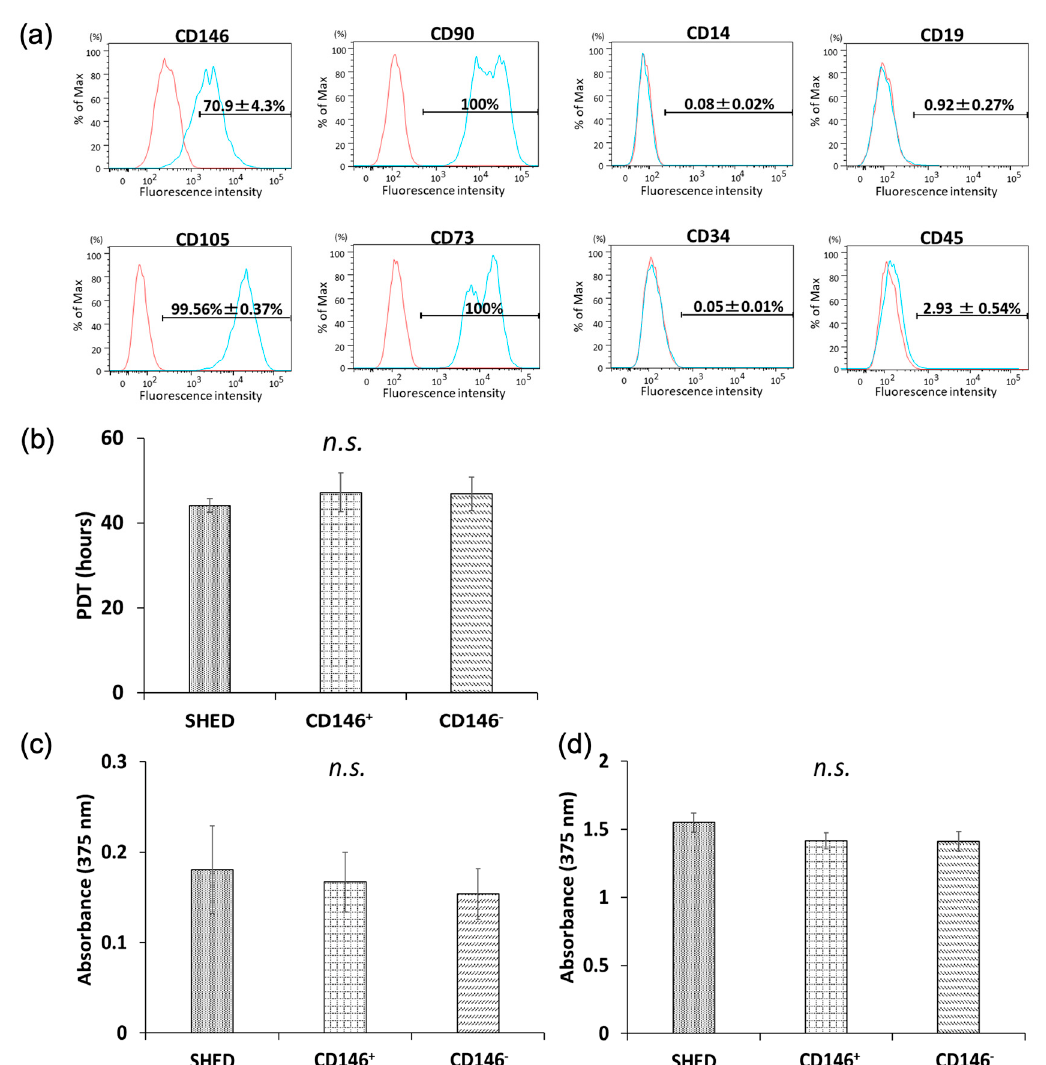
Figure 1. Surface-antigen analysis of SHED and comparative properties of SHED, CD146 + SHED, and CD146-SHED cellular proliferative potential. ( a ) Surface-antigen analysis of SHED. Among the heterogeneous population of SHED isolated from the deciduous pulp, 70.9 ± 4.3% of cells expressed CD146. MSCs were positive for CD90, CD73, and CD105 but negative for CD14, CD19, CD34, and CD45. ( b ) Comparison of population doubling time (PDT). The log phase was assessed based on the cell growth curve from day 2 to day 6 of incubation, and the PDT was calculated for this period. PDT did not differ significantly among the three groups ( n = 5, Kruskal–Wallis test, Not significant; N.S.) ( c , d ). Comparison of cell proliferation. ( c ) Two hours after BrdU treatment, DNA synthesized in SHED was slightly higher than that in CD146 + SHED and CD146-SHED, but there were no significant differences among the three groups. ( d ) Twenty-four hours after BrdU treatment, the results were similar ( n = 5, Kruskal–Wallis method, Not significant; N.S.).